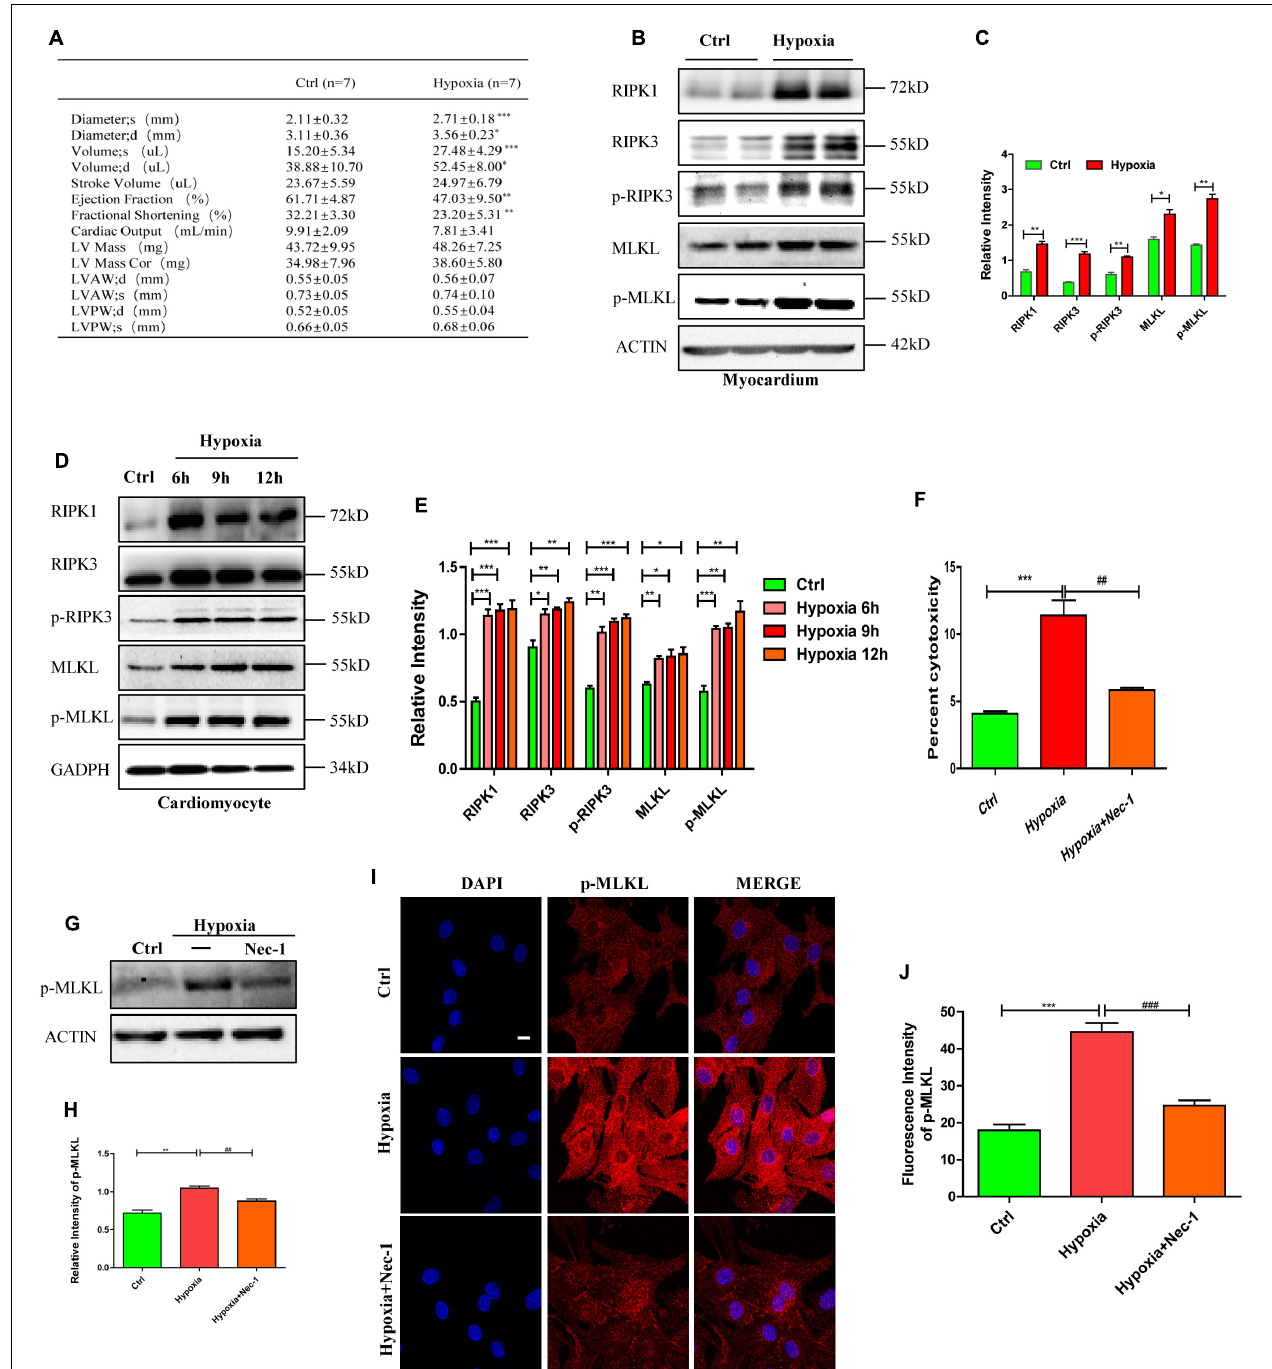
FIGURE 1 | Necroptosis mediates cardiac dysfunction caused by hypoxia. (A) Echocardiography was performed to evaluate cardiac function after hypoxia treatment. Means ± SEM, n = 7. * p < 0.05, ** p < 0.01, and *** p < 0.001 versus the control group. (B,C) Representative bands of western blotting and statistical analysis, which were performed to detect RIPK1, RIPK3, p-RIPK3, MLKL, and p-MLKL levels after hypoxia treatment in the myocardium, Means ± SEM, n = 5. * p < 0.05, ** p < 0.01, and *** p < 0.001 versus the control group. (D,E) Representative immunoblotting bands and statistical analysis of RIPK1, RIPK3, p-RIPK3, MLKL, and p-MLKL in cardiomyocytes after hypoxic treatment for different durations, n = 5. * p < 0.05, ** p < 0.01, and *** p < 0.001 versus the control group. (F) Lactate dehydrogenase (LDH) leakage analysis was performed to determine cell death. Mean ± SEM, n = 5. *** p < 0.001 versus the control group, ## p < 0.01 versus the hypoxia group. (G,H) Immunostaining and statistical analysis of p-MLKL from Ctrl, Hypoxia, and Hypoxia+Nec-1 groups. Mean ± SEM, n = 3. ** p < 0.01 versus the Ctrl group, ## p < 0.01 versus the Hypoxia group. (I,J) Representative confocal images and statistical analysis of p-MLKL after hypoxia treatment for 9 h. Scale bar, 10 µ m. n = 3, Mean ± SEM. *** p < 0.001 versus the control group, ### p < 0.001 versus the hypoxia